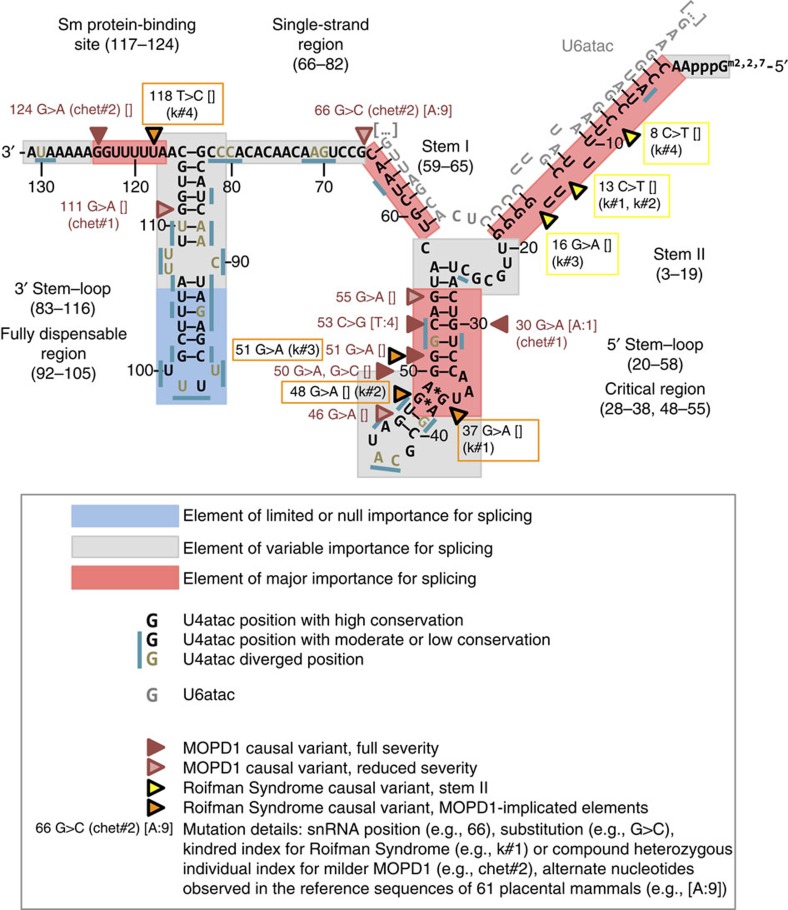
U4atac snRNA secondary structure elements, positional conservation, MOPD1 and Roifman Syndrome causal variants.Elements of limited or null importance for splicing (dispensable region of 3′ stem–loop) have mutagenesis experiments2021 showing no splicing alteration, are enriched in low conservation and do not present any known disease-causing variant. Elements of variable importance for splicing (3′ stem–loop, except dispensable region; single-strand region; 5′ stem–loop, except critical region) have mutagenesis experiments showing modest or no splicing alteration, or have not been probed by mutagenesis, but meet at least one of these criteria: (a) they present at least one MOPD1 causal variant (typically with reduced severity); (b) they are proximal to a MOPD1 causal variant cluster; (c) structural studies6061 suggest they may have a functional role; these elements have mixed conservation, and only a few variants at more conserved positions may cause splicing alterations. Elements of major importance for splicing (stem II, critical region of the 5′ stem–loop, stem I, Sm protein-binding site) have mutagenesis experiments producing splicing alterations and/or overlap the MOPD1 variant cluster; in addition, they are expected to have a major functional role based on structural studies; finally, they are enriched in highly conserved positions, the majority of which are expected to cause splicing alterations in presence of variation. Positions are labelled as ‘high conservation' if placental mammal or 100-vertebrate PhyloP ≥1.75, as ‘diverged' if placental mammal and 100-vertebrate PhyloP are negative, and ‘moderate or low conservation' otherwise. Parts of U6atac are displayed only in correspondence of U4atac–U6atac duplex structures. U4atac snRNA coordinate 1 corresponds to hg19 coordinate 122,288,456. Classification of MOPD1 causal variants as ‘full severity' or ‘reduced severity' is based on a thorough review of MOPD1 literature101115161718 (for more details, see Supplementary Table 17) and biochemical assays of variant effect22; the latter is particularly important for less severe MOPD1 forms presenting compound heterozygosity.